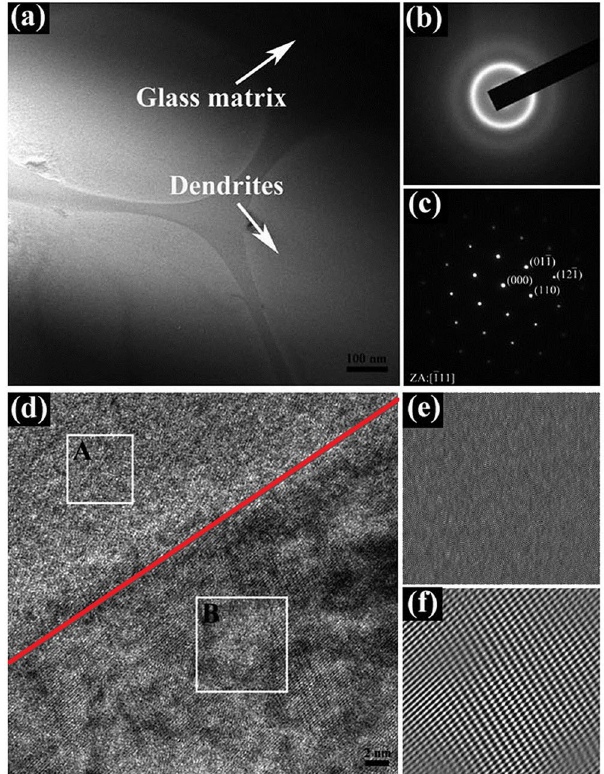
Figure 2. ( a ) BF TEM image of the present Ti-based MGMCs at low magnification; SAED patterns of ( b ) the matrix and ( c ) the dendrites; ( d ) HRTEM image taken near the interface; IFFT patterns of ( e ) the glass matrix and ( f ) the dendrites, marked by rectangles in ( d ), near the interface are shown in A and B,